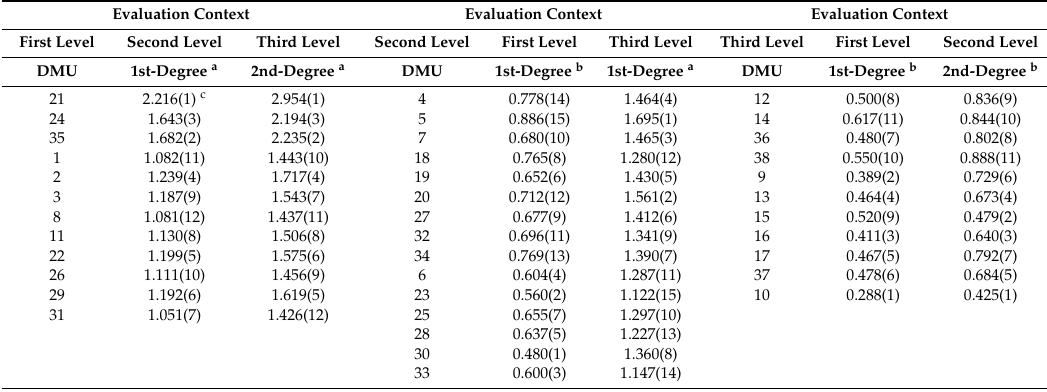
Table 5. Attractive and progress scores of the halfway